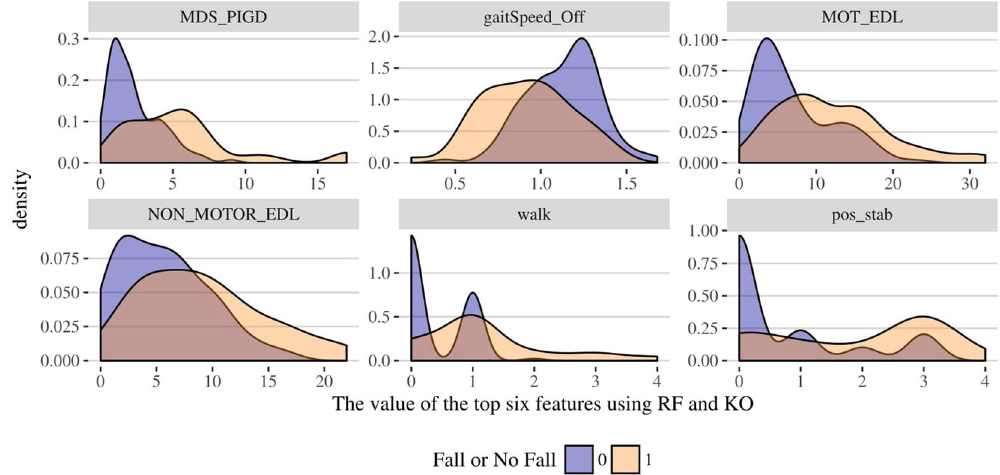
Figure 9. Density plots showing the top six clinical features with significantly different distributions between falls and no-fall cohorts within the Michigan study.